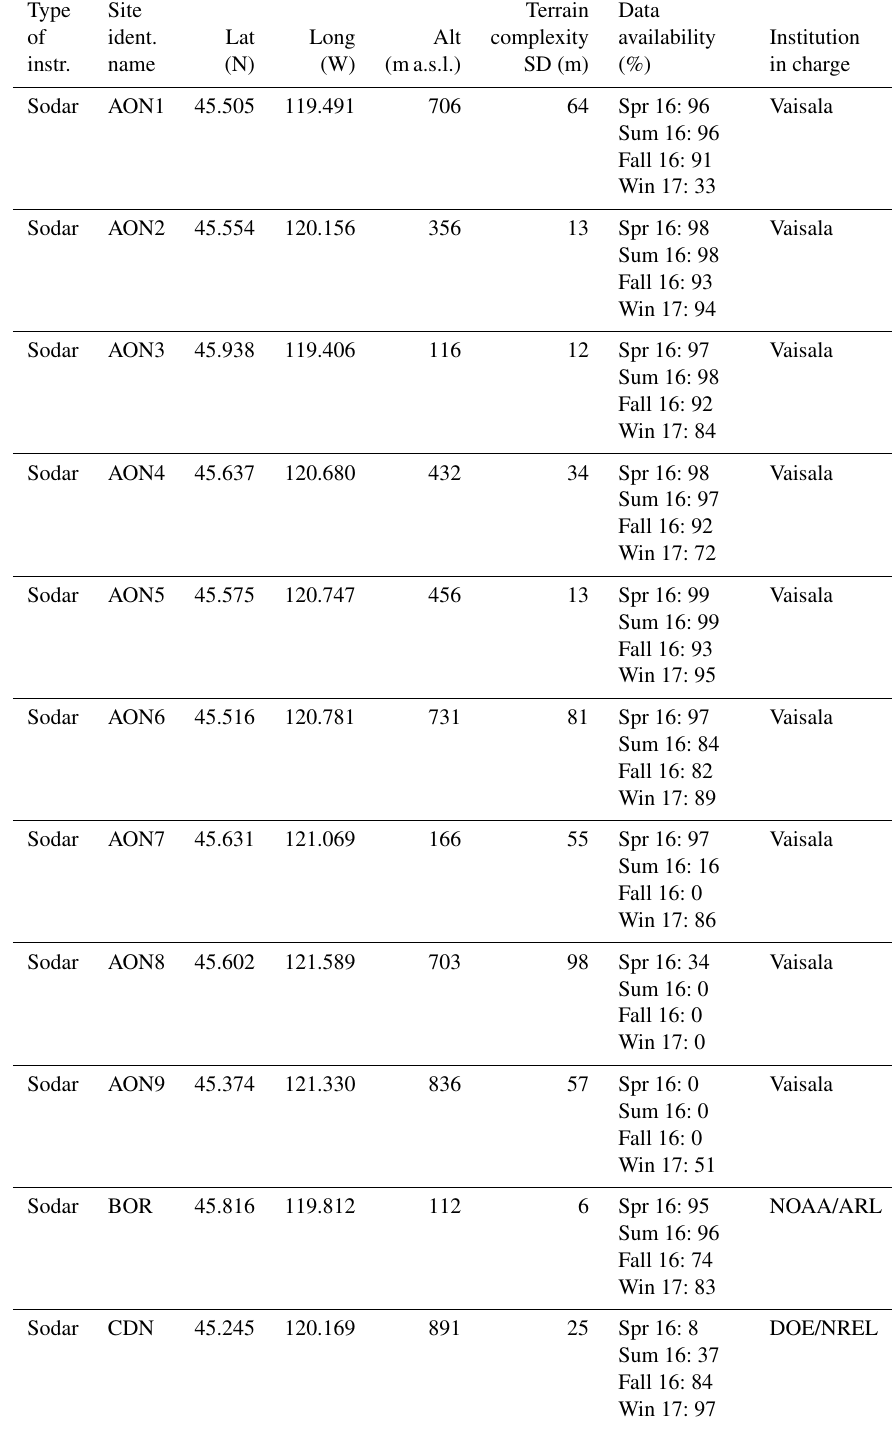
Table 1. List of the instruments used in this study with site identification name, latitude, longitude, elevation, terrain complexity, percentage of data availability, and institution in charge (ANL: Argonne National Laboratory; ARL: Air Resources Laboratory; CU: University of Colorado; LLNL: Lawrence Livermore National Laboratory; NREL: National Renewable Energy Laboratory; PNNL: Pacific Northwest National Laboratory; UND: University of Notre